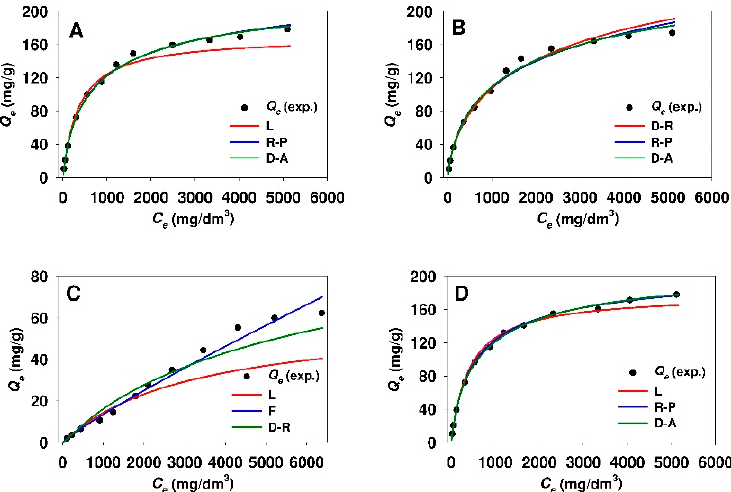
Figure 10. Comparison of experimental and predicted isotherms of 18 β -glycyrrhetinic acid adsorption onto ( A ) SBA-15-AP, ( B ) SBA-15-MAP, ( C ) SBA-15-DMAP, and ( D ) SBA-15-AEAP mesoporous adsorbents. The best fitted isotherm models derived from linear analysis are presented. Isotherm models: F, Freundlich; D-A, Dubinin-Astakhov; D-R, Dubinin-Radushkevich; L, Langmuir; R-P, Redlich-Peterson.